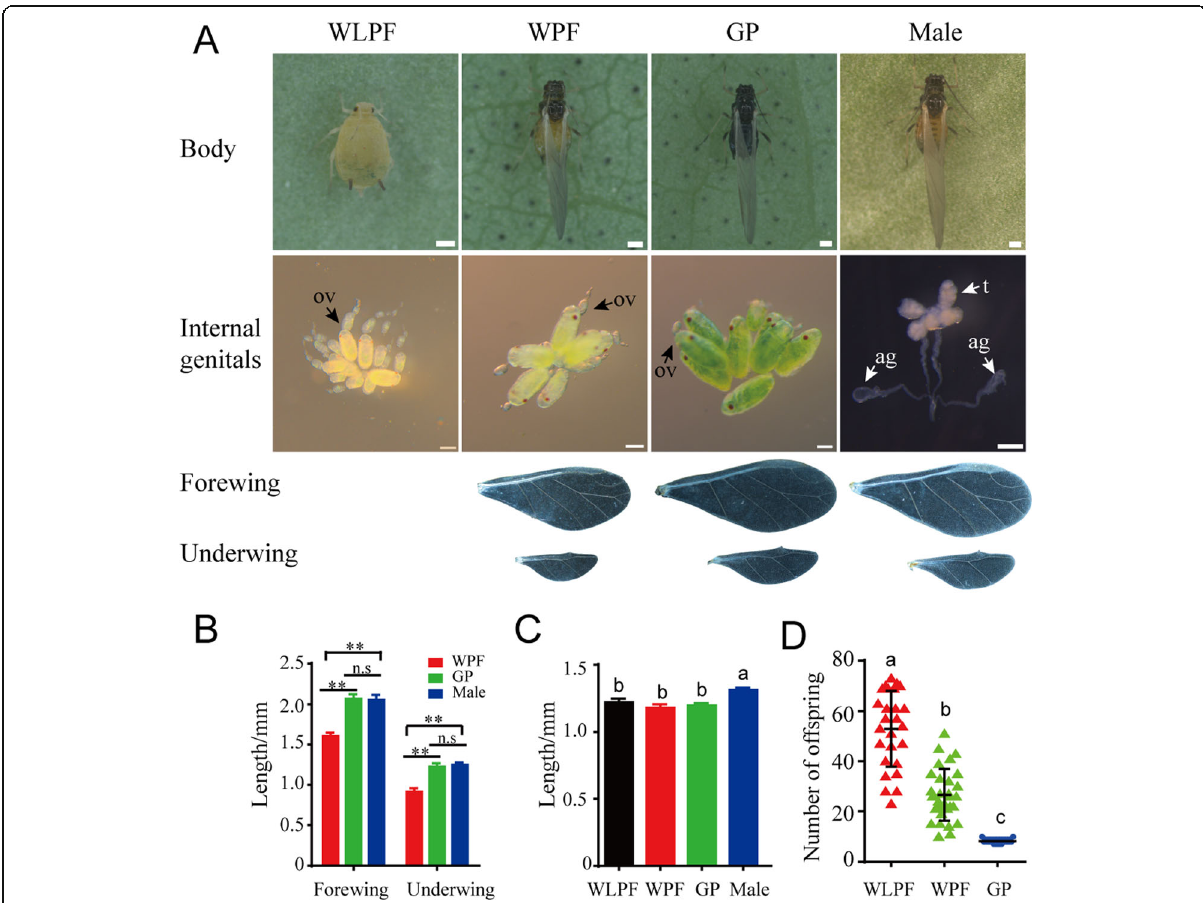
Fig. 3 Bodies, internal genitals, and fecundity of four morphs in cotton aphid. a Body, internal genital, forewing and underwing morphologies of WLPF, WPF, GP, and male obtained in laboratory condition. ov, ovariole; ag, accessory gland; t, testes. Scale bars, 0.2 mm. b Length of forewing and underwing of WPF, GP, and male. c Body length of WLPF, WPF, GP, and male with the exception of antennae and wings. d Fecundity of WLPF, WPF, and GP. The offspring of individual WLPF, WPF, and GP were counted. Asterisk indicates significant differences between two morphs (Student ’ s t test, **, P < 0.01). Different letters indicate significant differences ( P < 0.05) obtained using Tukey ’ s multiple range tests. The length of